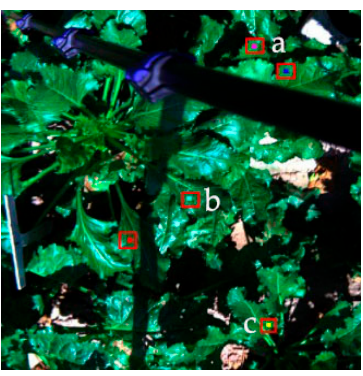
Table 3. The number of samples used in calibration and validation for the three studied growth stages. Calibration Set Validation Set Stage